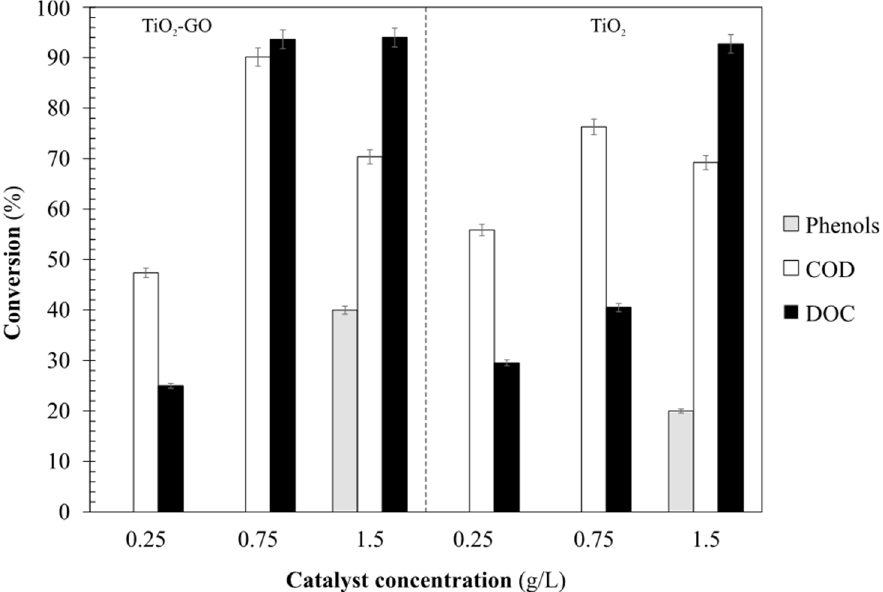
Figure 8. Removal efficiencies of chemical oxygen demand, phenols and dissolved organic matter Figure 8. Removal e ffi ciencies of chemical oxygen demand, phenols and dissolved organic matter after after the photocatalytic process with TiO 2 -GO and TiO 2 . the photocatalytic process with TiO 2 -GO and TiO 2